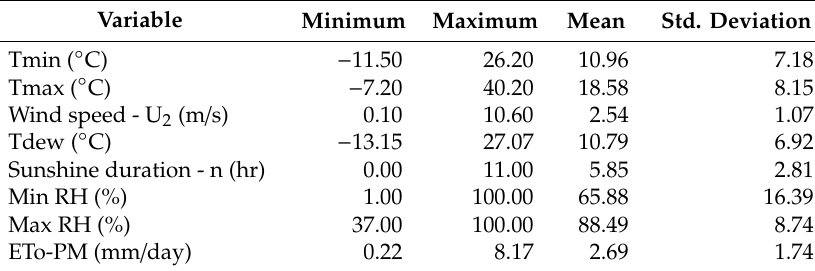
Table 2. The correlation matrix of the meteorological variables